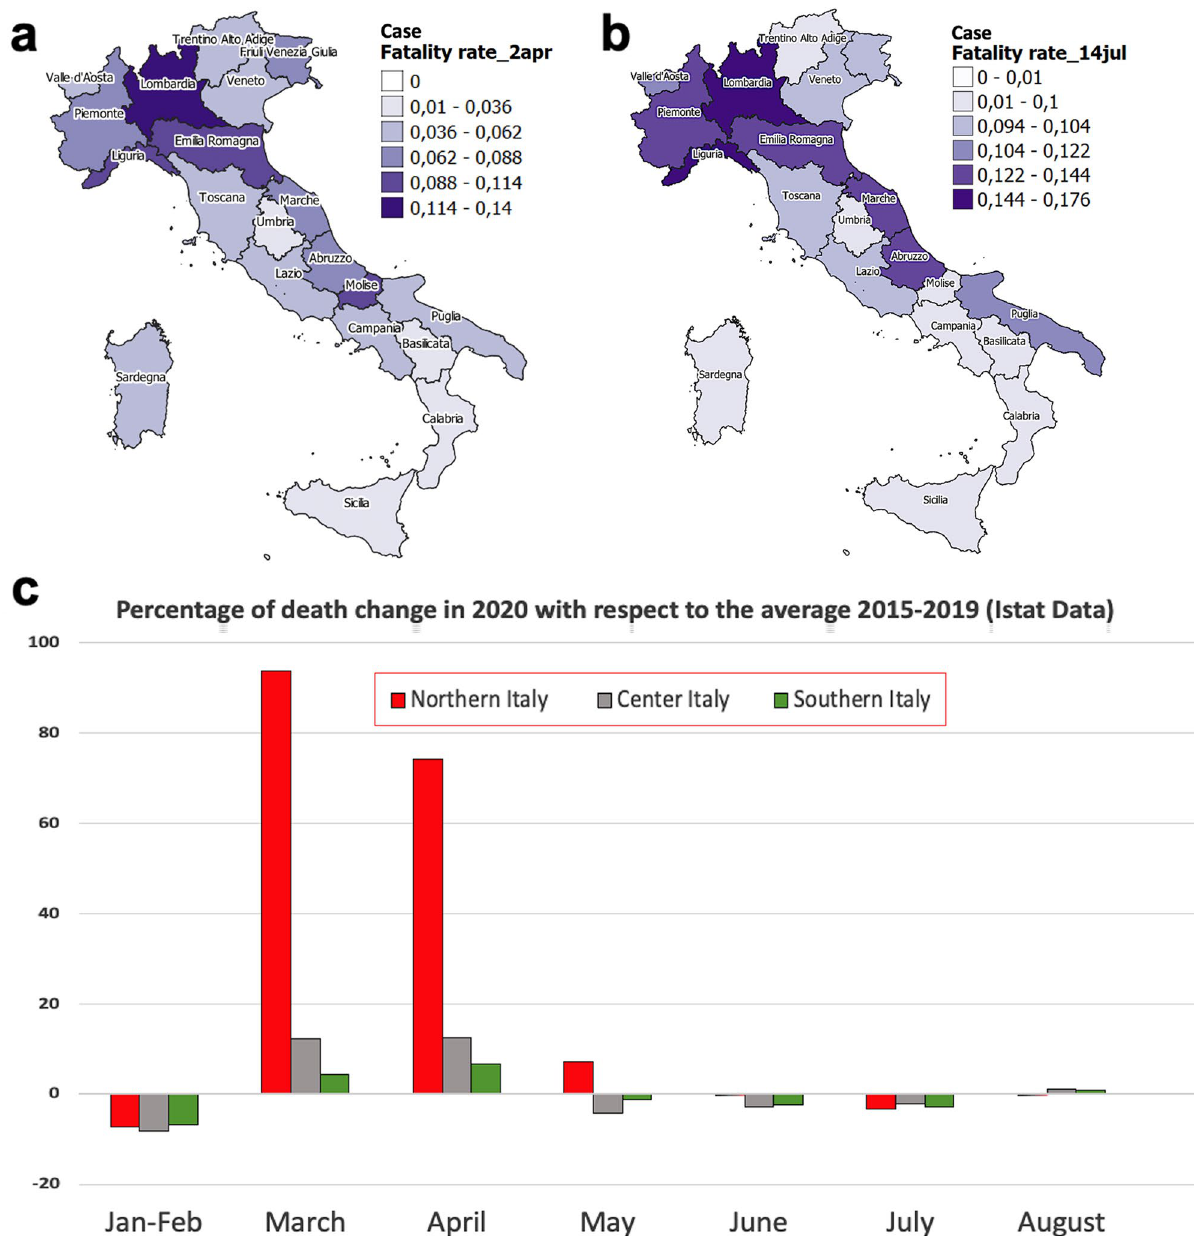
Figure 1. ( a ) Color geographic maps of the apparent case fatality rate in the various regions on April 2, 2020 and on July 14, 2020 ( b ), data released by the Italian Ministry of Health 4 . Maps were realized with QGIS 3.10 (https:// qgis. org/ en/ site/). ( c ) Percentage of deaths change in 2020 with respect to the average taken in the period 2015–2019 (ISTAT 22